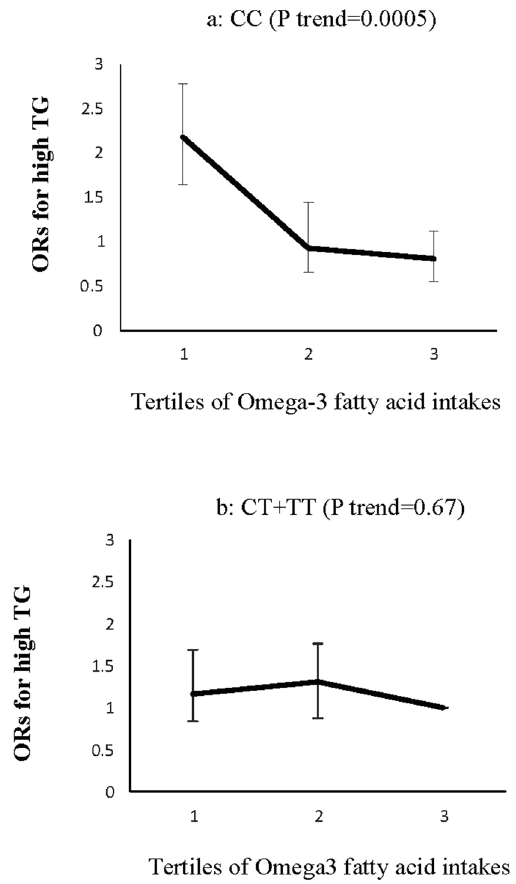
Figure 3. Adjusted ORs for high triglycerides (TG) across tertiles of omega-3 fatty acid intakes by the ZNT8 genotypes (P interaction = 0.05); CIs are shown after the bootstrap analysis (T1 < 0.38, T2:0.38–0.54., T3 > 0.54% of energy). The risk of high TG decreased across tertiles of omega-3 fatty acid intakes in CC genotype carriers ( a ), a trend not observed in the CT + TT genotype groups ( b